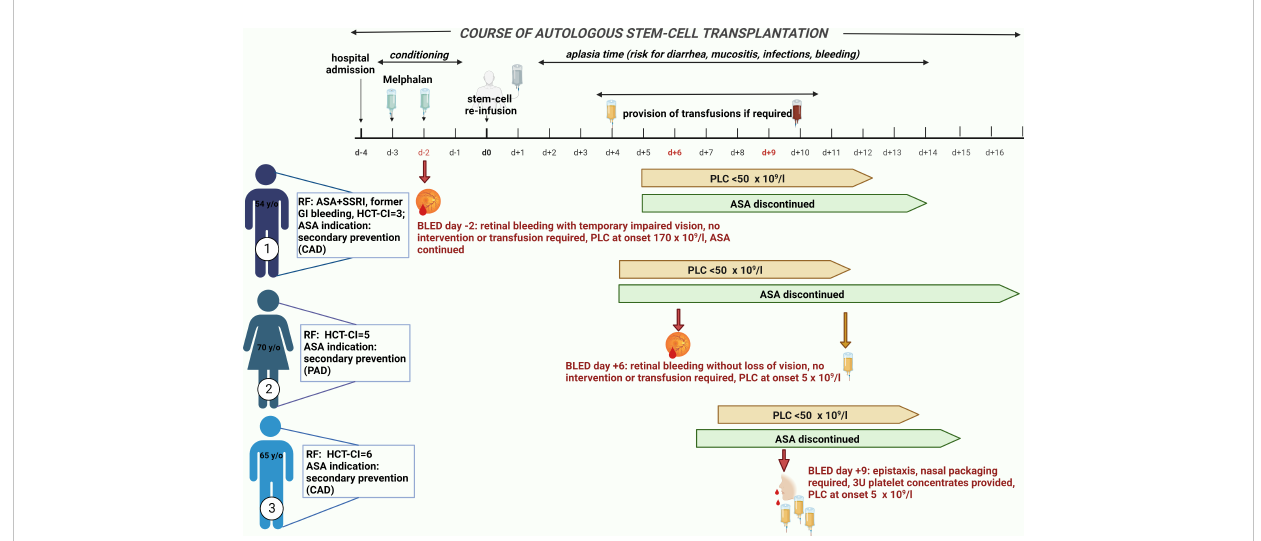
Table 2. A total of 477 (42.9%) patients received no PLTX at all; 481 (43.2%) received only one unit. Patients with ASA